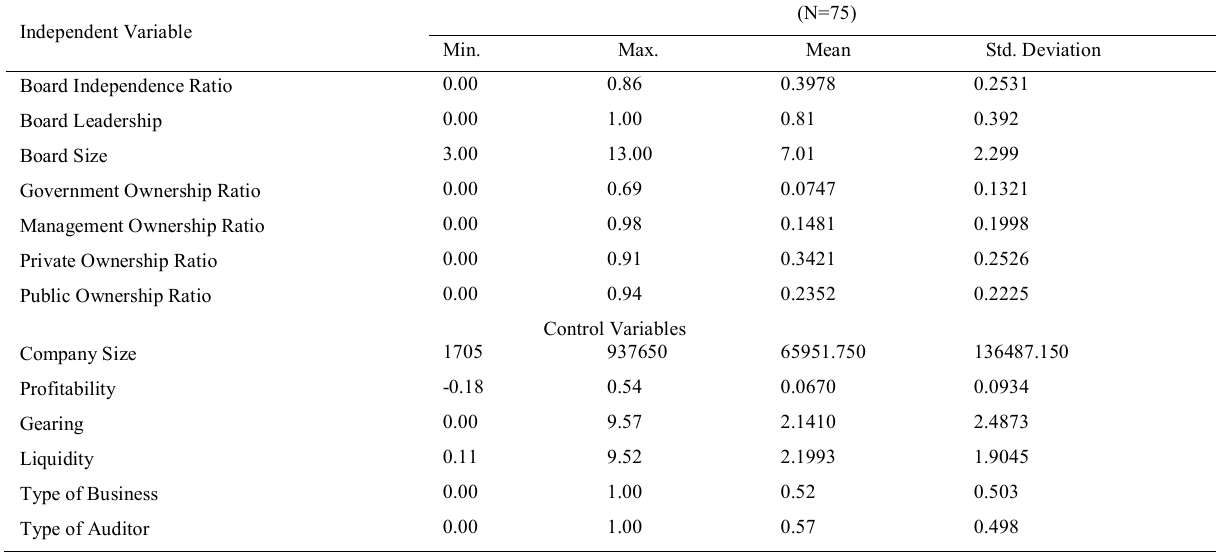
Table 2. Summary of Descriptive Statistics for Independent